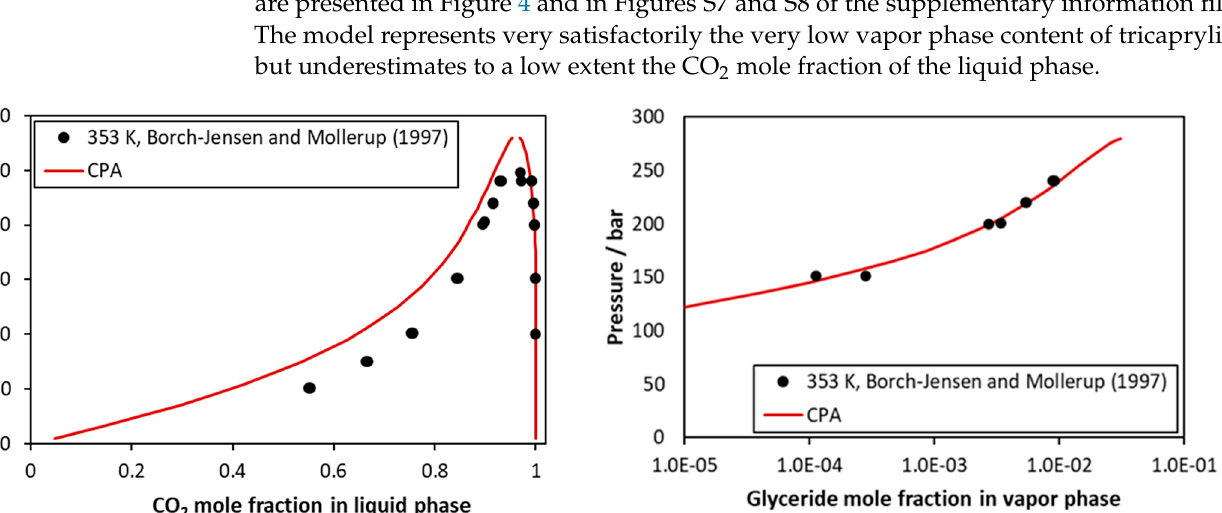
Figure 5. CO 2– tributyrin VLE at 298 K. Experimental data [44,45] and CPA correlations using the binary interaction parameter of Table 5.